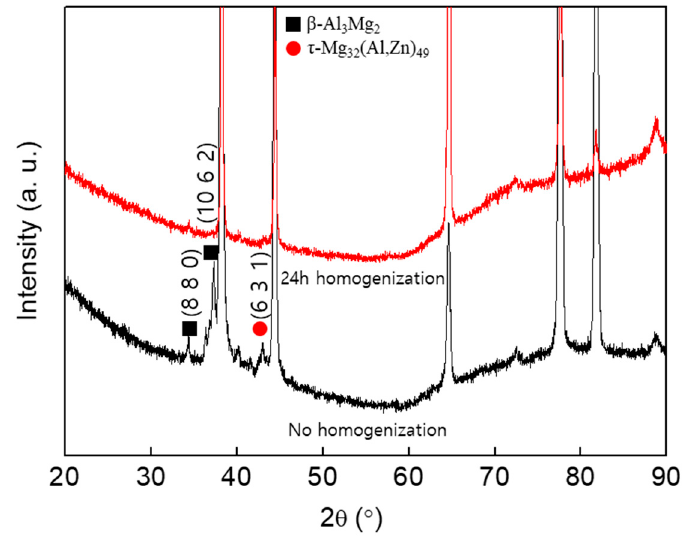
Figure 5. XRD analyses with no and 24 h homogenization.